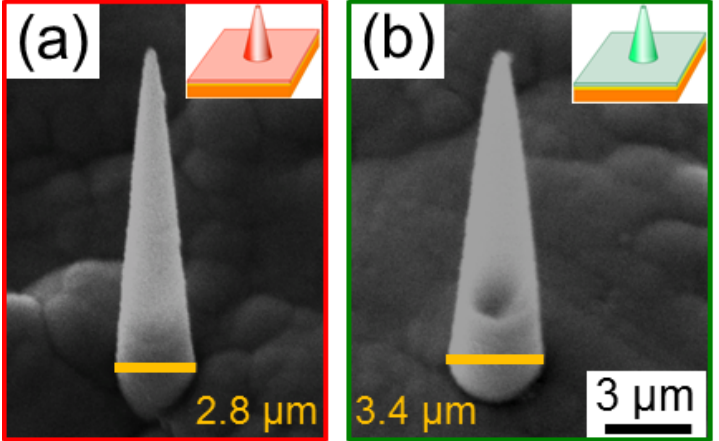
Figure 3. SEM images of free-standing single conical nanotubes of Al 2 O 3 ( a ) and TiO 2 ( b ). The cones are stable although the tube wall consists of a ~15 nm thick ALD layer.